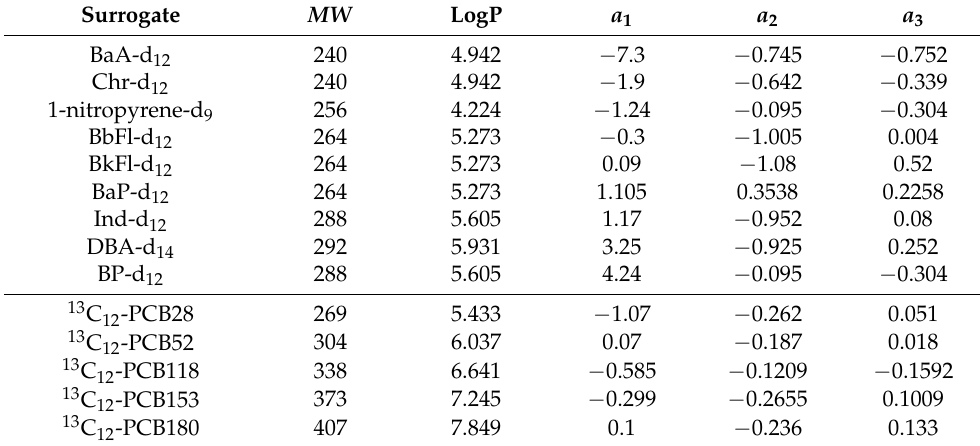
Table 4. a i coefficients of linear terms retrieved from the 2 3 full factorial design of each surrogate. Surrogate MW